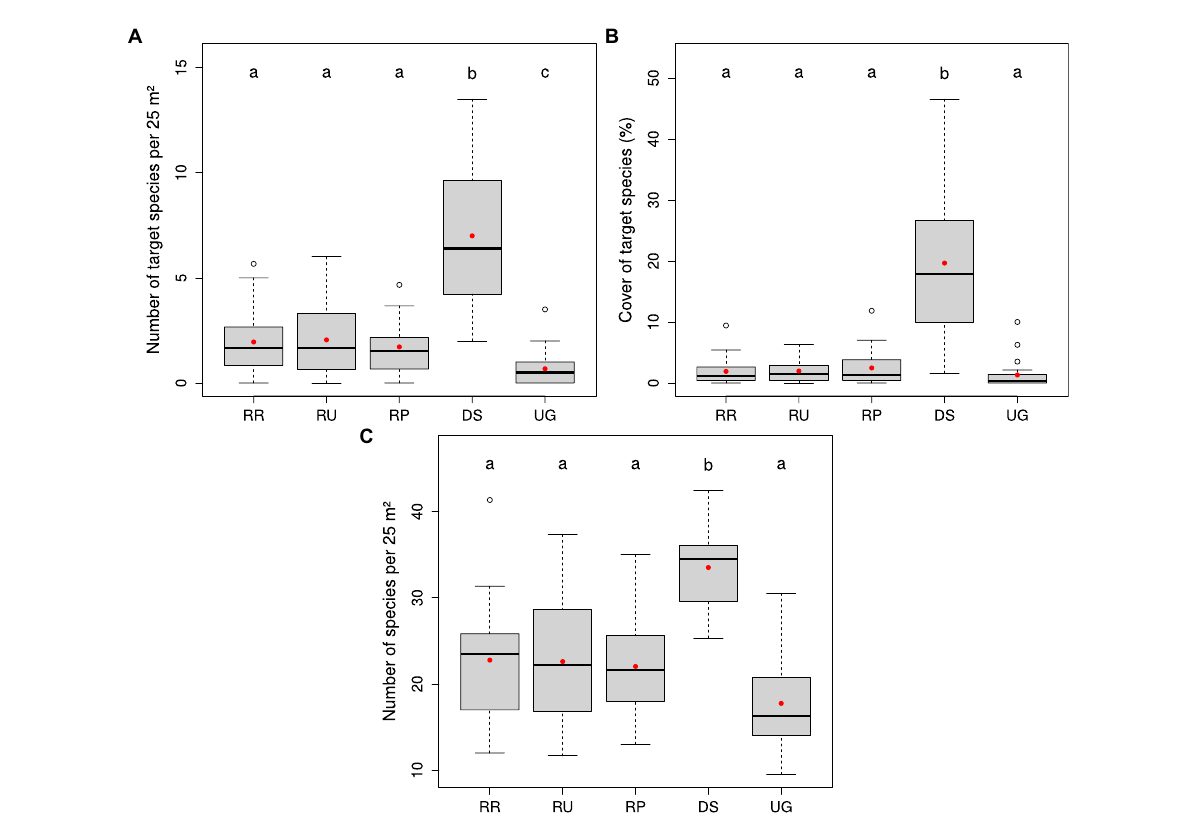
FIGURE 4 Box-whisker plots of the number of target species per plot (A) , the cover of target species (%; B ), and the number of species per 25 m 2 plot (C) in 2021 on the different site categories—donor sites (DS, n = 8), all restoration sites with treatments ploughed (RP), rotovated (RR), and untilled (RU), and unrestored reference grassland (UG; n = 20, respectively). Plot data were averaged on the treatment level or, in case of DS and UG, on the site level. Red dots display the mean values. Significant differences ( p < 0.05) are indicated by different letters above the boxes (testing on ln- transformed data for number and cover of target